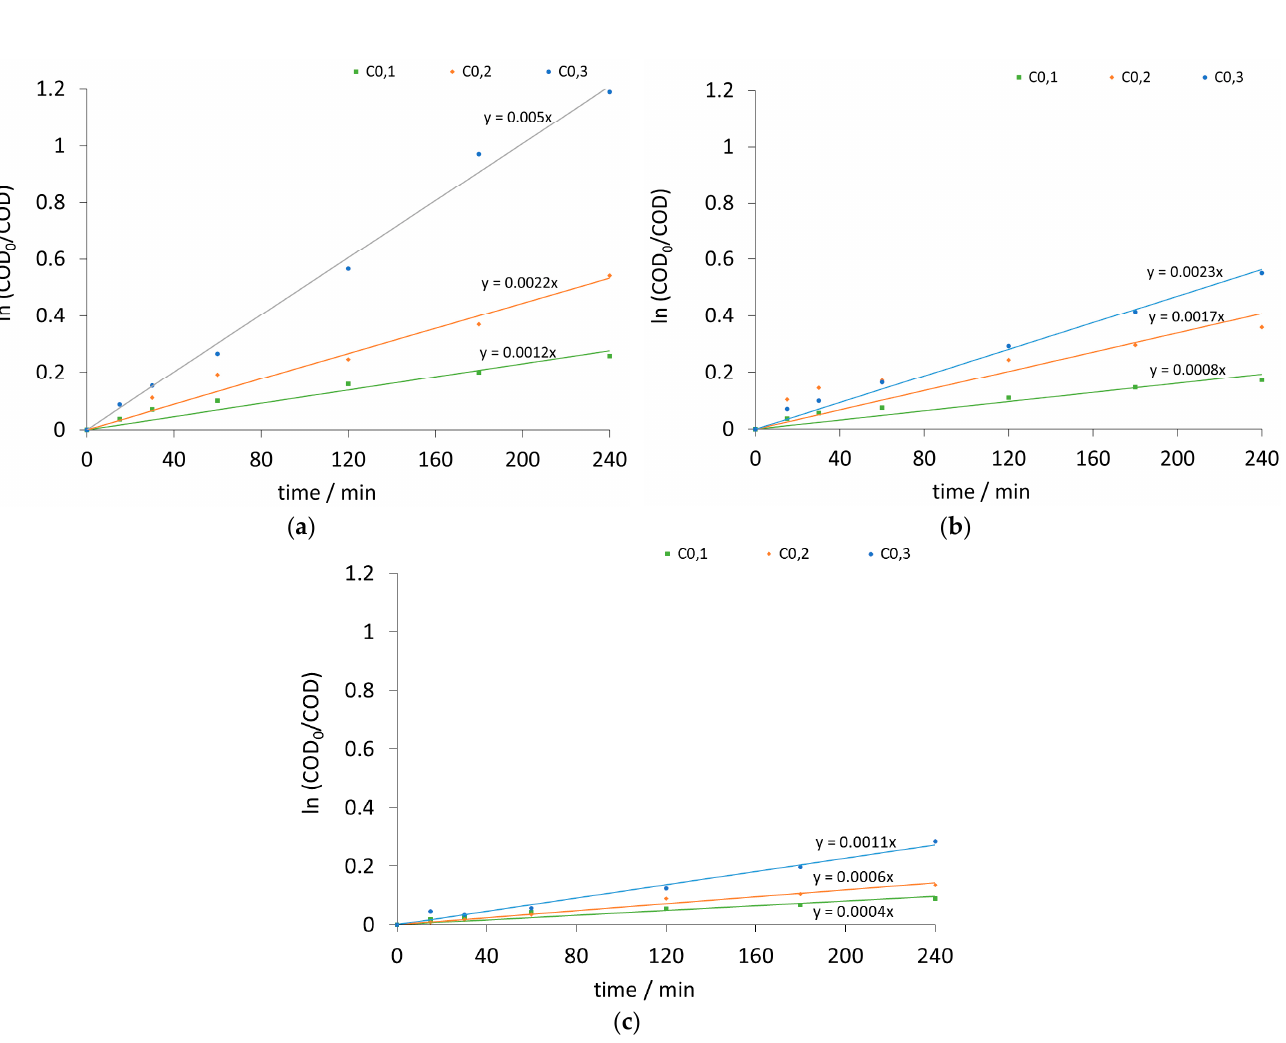
Figure 5. Kinetic curves of the electrochemical reaction as a first-order reaction at different current densities: ( a ) at 100 mA/cm 2 ; ( b ) at 50 mA/cm 2 ; ( c ) 20 mA/cm 2 , and different concentrations: C 0,1 (square), C 0,2 (diamond), and C 0,3 (circle) .